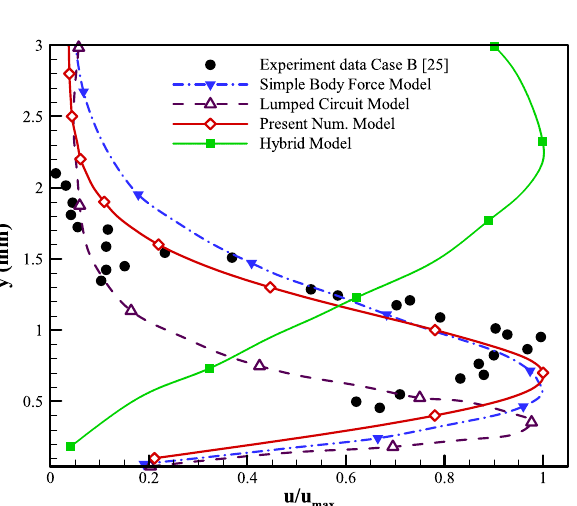
Figure 15. The results from the presented numerical model compared to the experimental and other numerical vertical velocity profiles on actuator geometry of Case A.